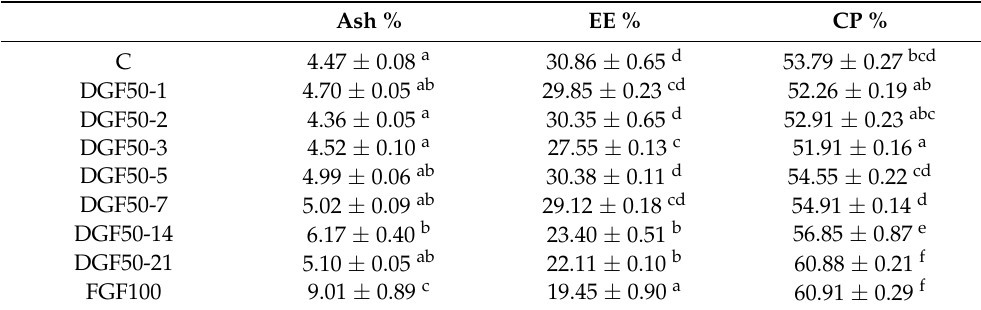
Table 3. Proximate composition (%) of Tenebrio molitor larvae fed with fish-based